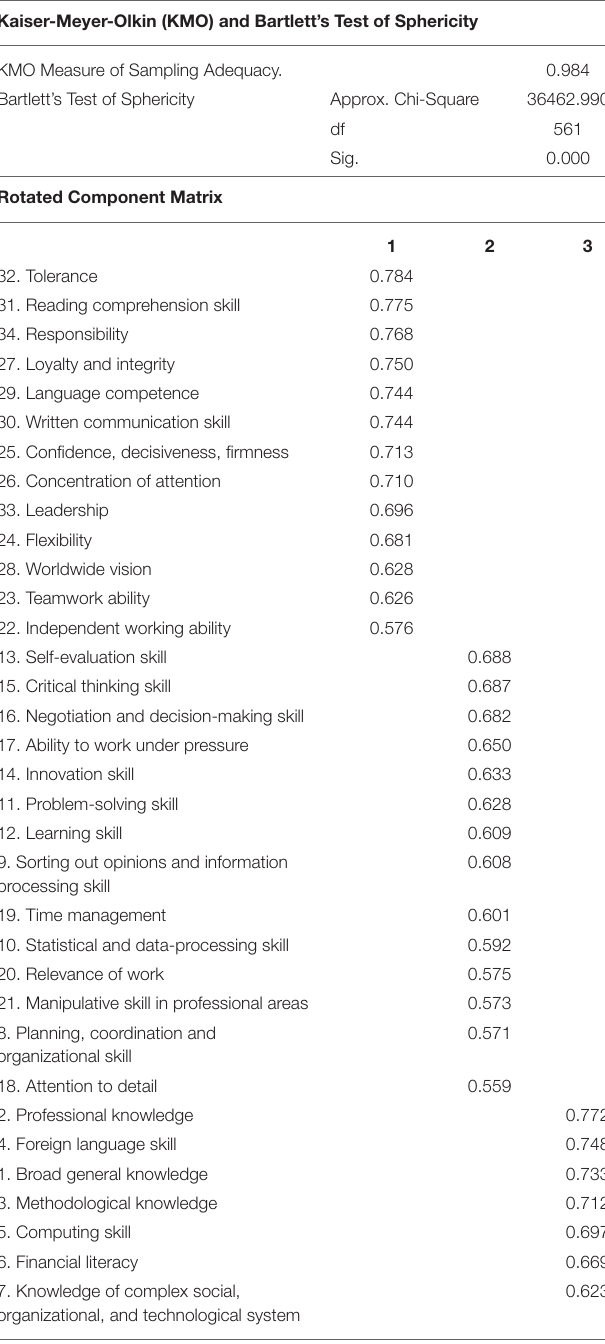
Extraction Method: Principal Component Analysis. Rotation Method: Varimax with Kaiser